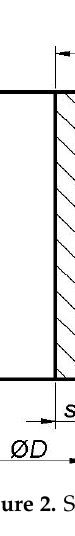
Figure 1. Axisymmetric parts with flanges.